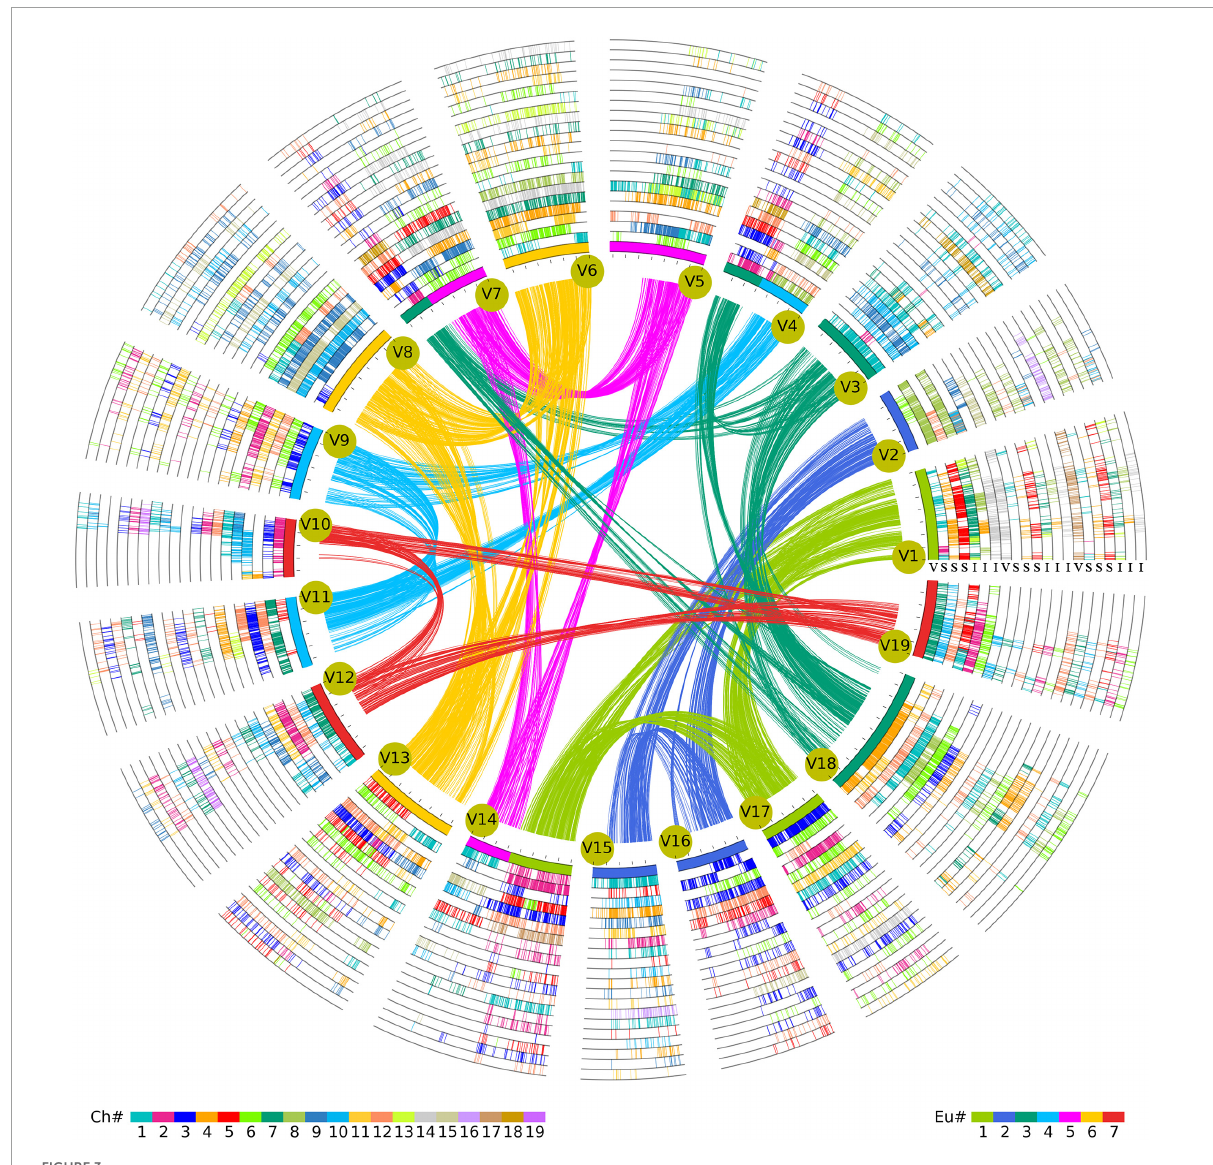
FIGURE3 Multigenomic alignment framework for Solanales genomes. Homologous alignments were performed with Vitis vinifera (V) as a reference. V. vinifera chromosomes form the innermost circle, and their paralogous syntenic genes are linked curves. Exhibiting the information of three plants, including genomic paralogous, orthologous, and outparalogous relationships, each of the three sets of V. vinifera paralogous chromosomal regions has three orthologous copies in Solanum lycopersicum , forming 3 × 3 = 9 circles, and three orthologous copies in Ipomoea triloba, forming 3 × 3 = 9 circles. Finally, 21 circles are formed, each corresponding to Figure 2D . The Ch color scheme at the bottom is based on V. vinifera ; if the genes of V. vinifera and S. lycopersicum / I. triloba are homologous, lines of corresponding colors are displayed in the circle. Eu corresponds to the colors of the seven chromosomes of the ancestor before the core eudicot common hexaploidization (ECH) event, and the innermost reference genome is the corresponding color of